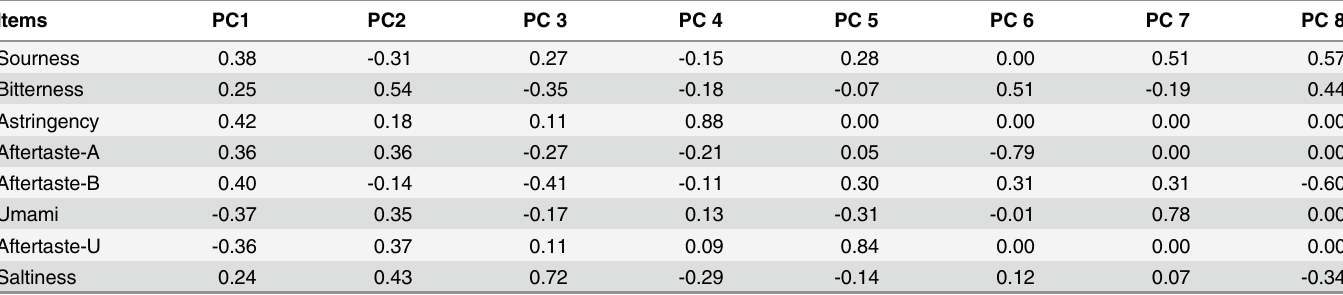
saltiness, bitterness, astringency, Aftertaste-A and Aftertaste-U, and the rest of two negative flavor traits including sourness and Aftertaste-B. Bitterness had a highest positive correlation with PC-2. In the spatial distribution of the PCA graphic, three clusters existed on the PCA map showed an easily visible separation of the different breeds with different colors, which could help us make the rapid identification on different breeds of beef. Legin et al (2003) found that the electronic tongue distinguished all wine samples of the same denomination and vintage [6]. Beullens et al. (2008) demonstrated that electronic tongues were very well suited to classify tomato cultivars based on their taste profile [26]. In addition, Silva et al. (2012) also reported that the electronic tongue could distinguish five different soybean cultivars through flavor attri- butes [27]. Table 4. Eigenvalues of the flavor traits within the Principal